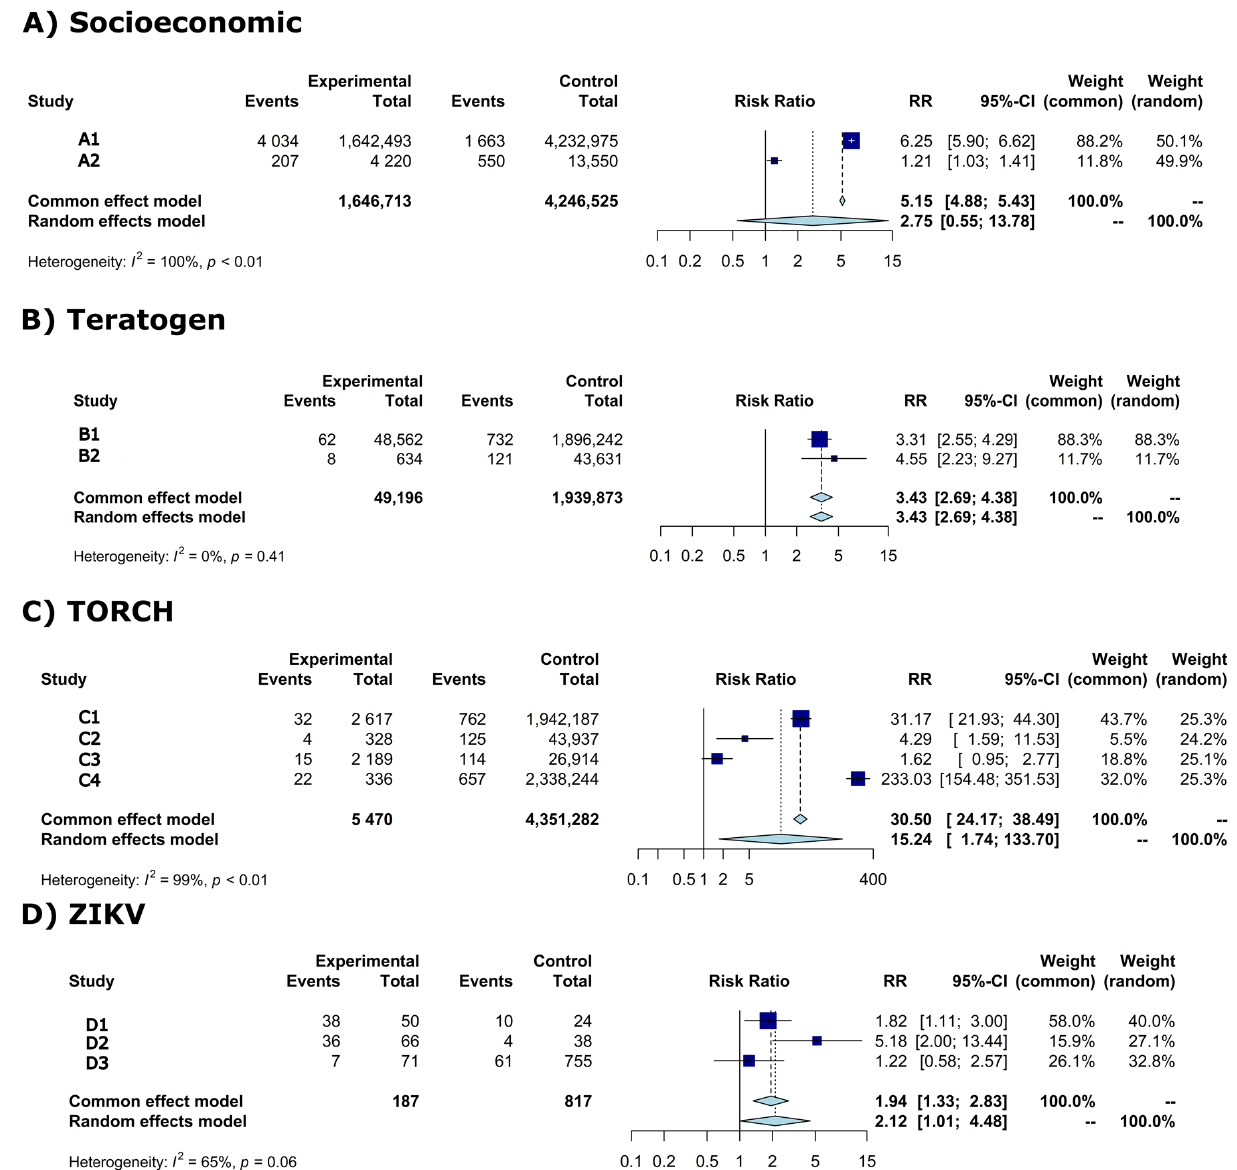
Figure 2. Forest plot of risk ratio ( RR ) and 95% confidence intervals (95%-CI) with light-blue dia- monds representing meta-analysis results and dark-blue squares individual study results per risk factor. Vertical solid black line ( RR = 1) is the risk effect threshold. Dashed black line is the overall microcephaly risk effect from the common effect and random effects model. ( A ) Socioeconomic, ( B ) Teratogen, ( C ) TORCH, ( D ) ZIKV. A1 = Campos et al., 2018 [24]; A2 = Silva et al., 2018 [25]; B1 = Auger et al., 2018 [26]; B2 = Liu et al., 2019 [27]; C1 = Auger et al., 2018 [26]; C2 = Liu et al., 2019 [27]; C3 = Shen et al., 2021 [5]; C4 = Messinger et al., 2020 [29]; D1 = Mendes et al., 2020 [30]; D2 = Robbiani et al., 2019 [31]; D3 = Barsosio et al., 2019 [32]. Table 2 shows results from quality analysis of selected studies by the GRADE system. These results are convergent to both the forest and funnel plots shown previously. Meta- analyses of socioeconomic and TORCH risk factors were classified as low quality, whereas those for teratogen and ZIKV were of high and moderate qualities, respectively (Table